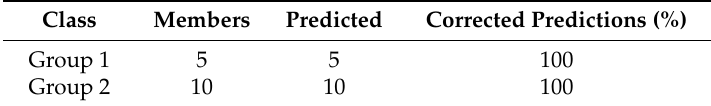
Table 2. Average misclassification table for validation of the OPLS-DA